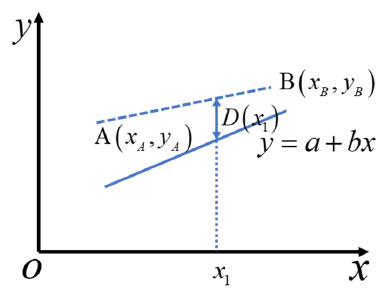
y x and . Figure 5. Diagram for determining the relationship between x and y